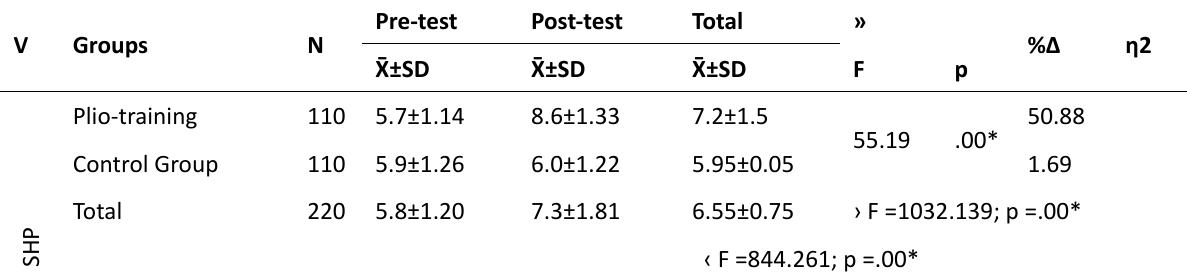
Table 2. Impact of plyometric training in the shot put technique performance level